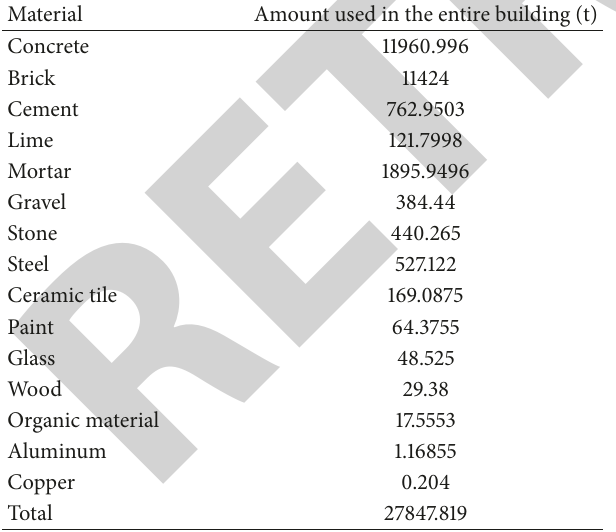
Table 1: Quantities of main building materials used in the RRSAB.